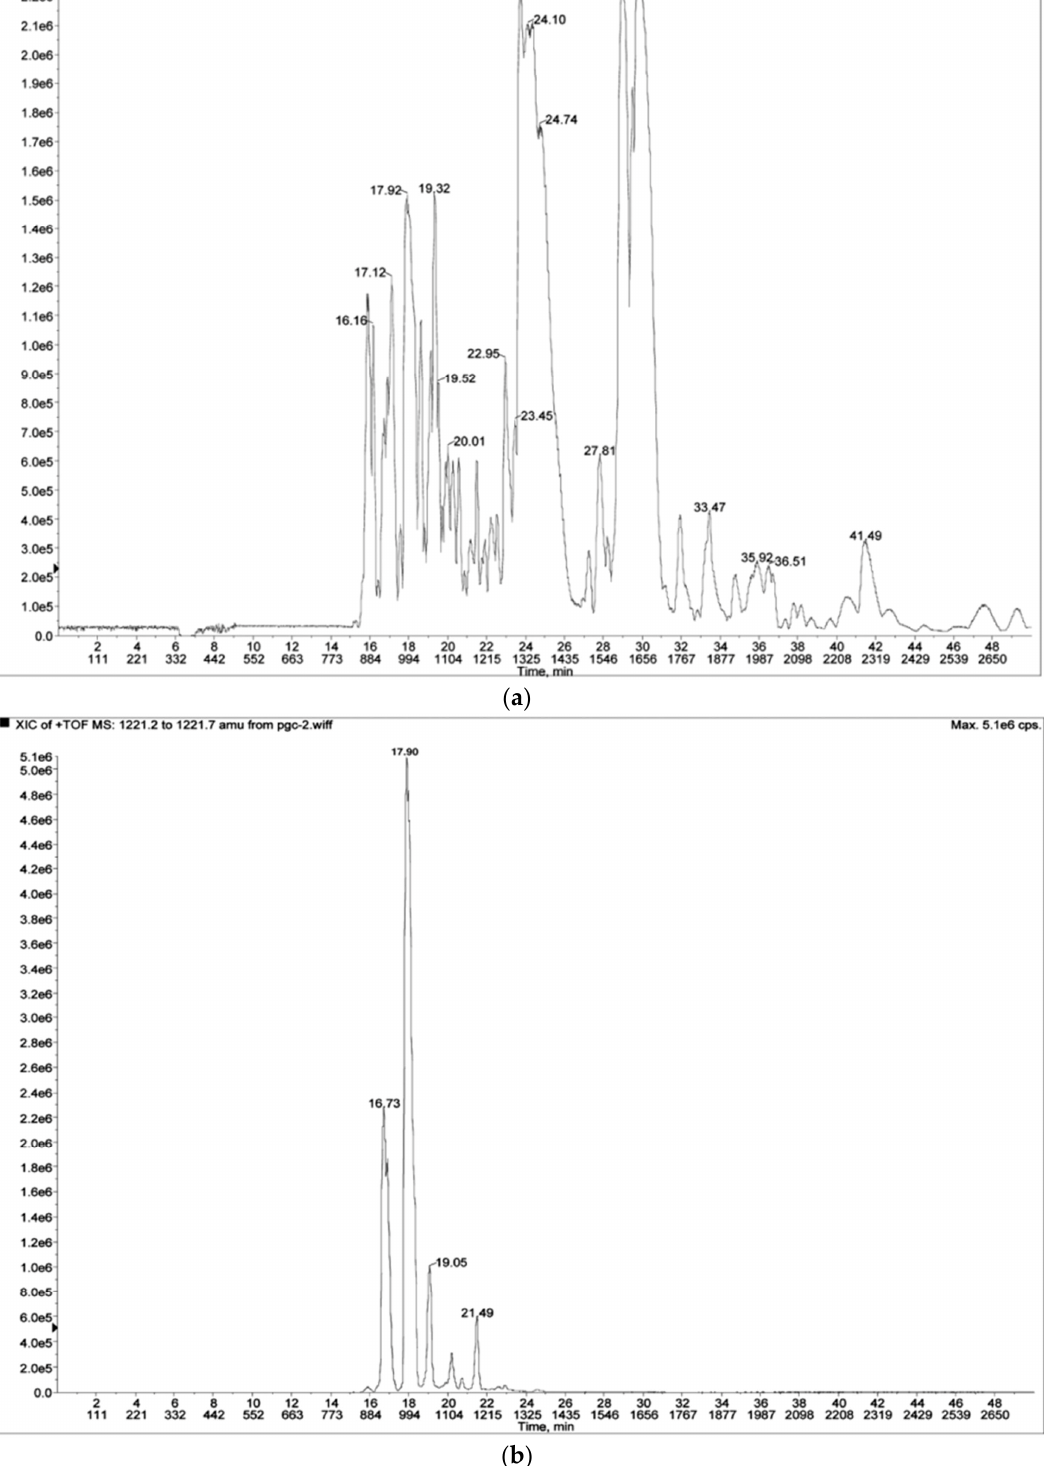
Figure 10. LC-MS of an HMO mixture. ( a ) Base peak chromatogram; ( b ) Extracted ion chromatogram of m / z = 1221.5, showing several isomers. Reproduced with permission from [50]. Copyright American Chemical Society, 2005.